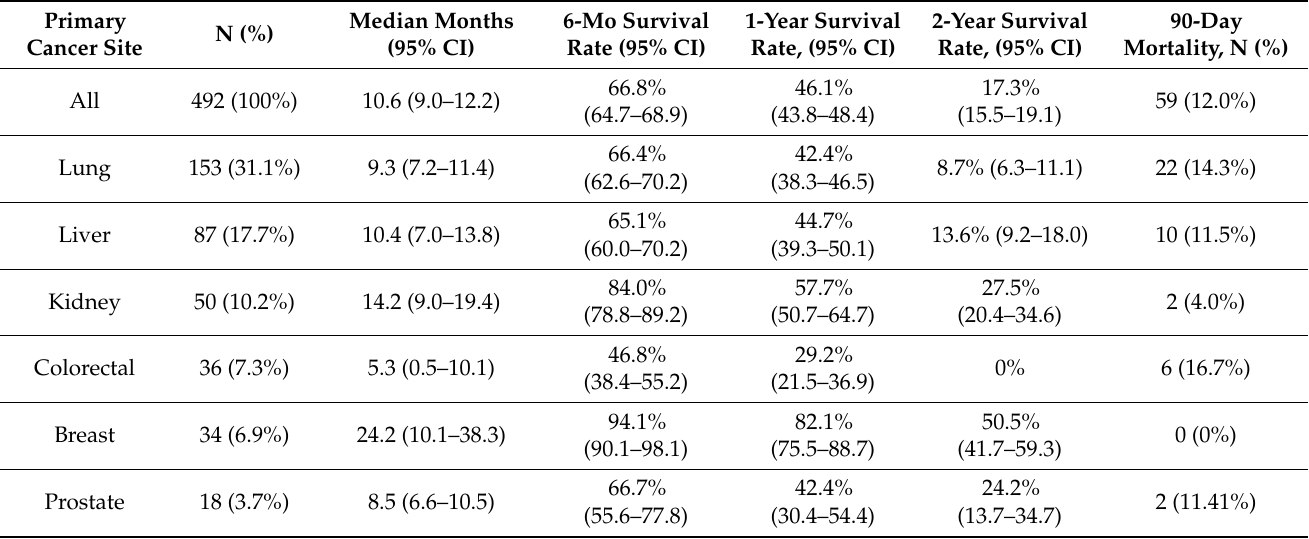
Table 3. Overall survival data according to the top six common primary cancer sites.